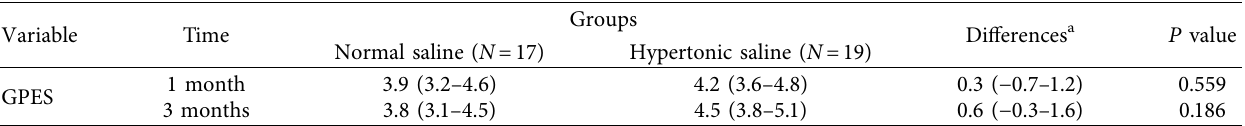
Table 5: Changes in the estimated global perceived efect of satisfaction after epidural block with or without hypertonic saline in patients with postherpetic neuralgia.